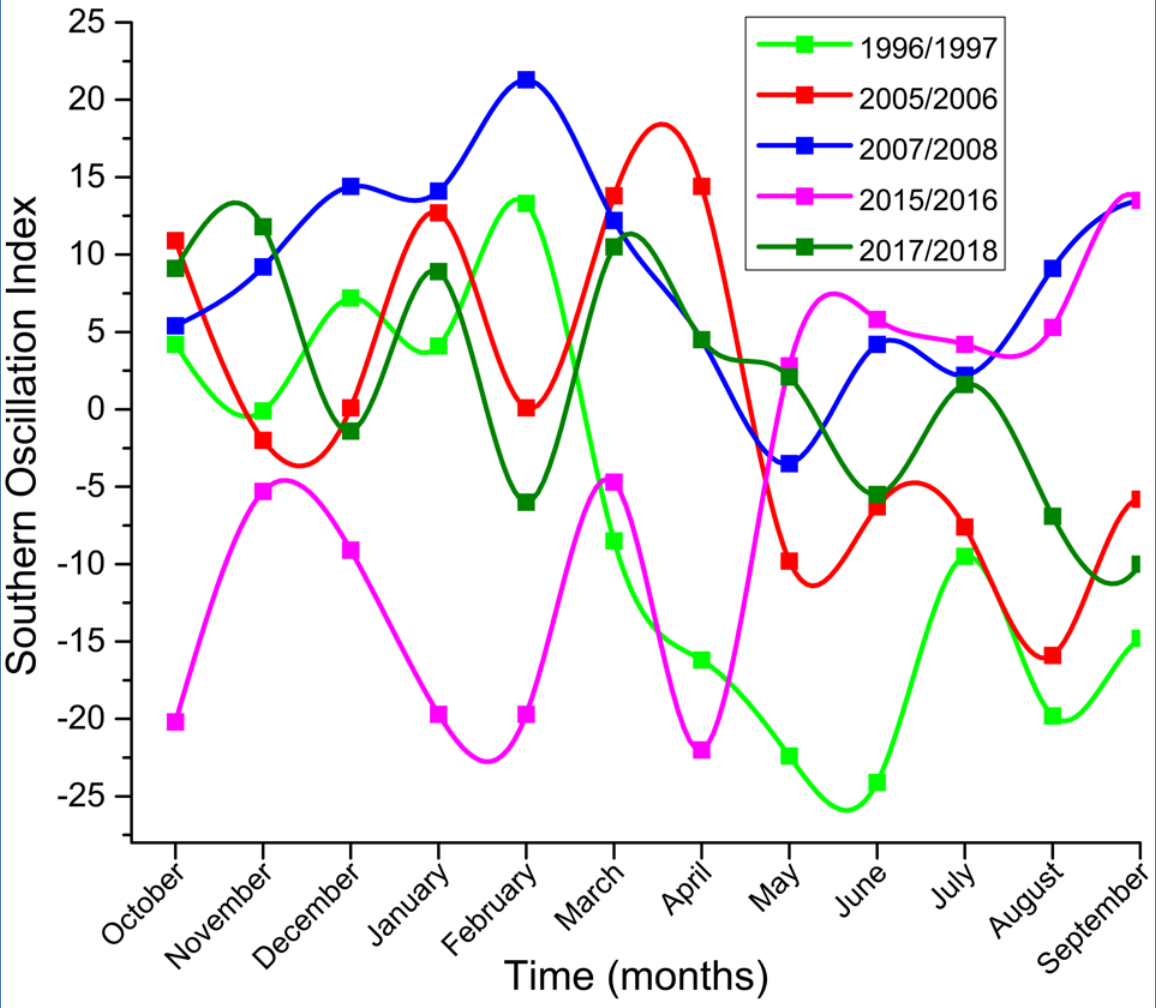
Figure 11. The graph of Southern Oscillation Index for depicting the influence of El Nino and the Southern oscillation on rainfall.